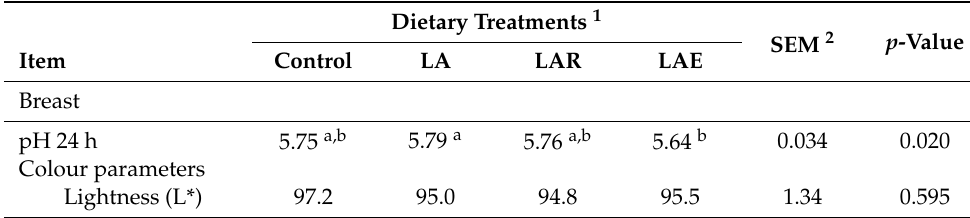
Table 4. Meat quality and carcass traits of broilers ( n = 10). Dietary Treatments